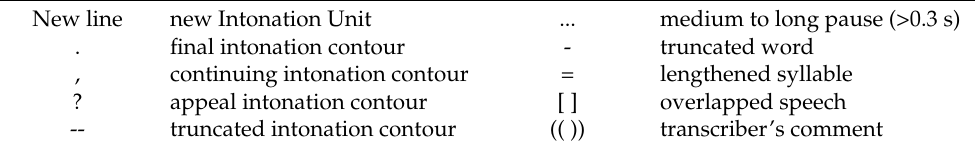
Table A6. Transcription Conventions (Du Bois et al.